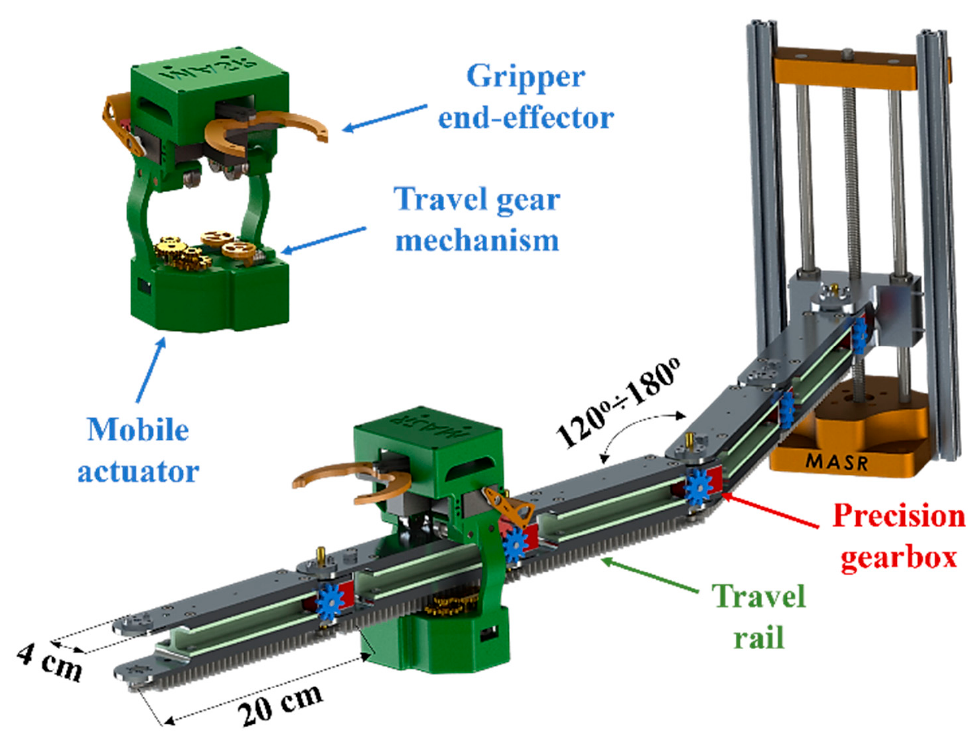
Figure 1. Mechanical design of the MASR robot. In this example, the robot consists of a planar serial arm with five passive joints actuated by a mobile actuator. The mobile actuator, which can travel over the links, is fitted with a gripper to carry objects along its path. The vertical motion is actuated by a linear lift unit, based on a stepper motor with a lead screw [9] .